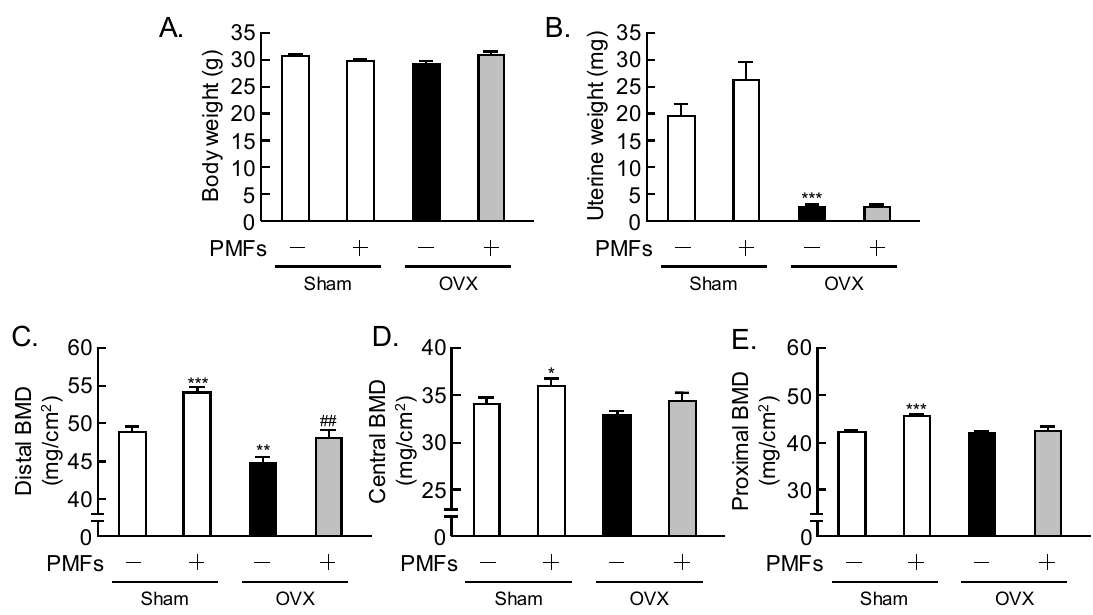
Figure 2. PMFs restored bone loss due to estrogen deficiency in mice. Female mice were ovariectomized (OVX) and sham-operated, and some mice were orally administered PMFs (5 mg/day/mouse) daily. At 4 weeks after the surgery, the body weight ( A ) and uterine weight ( B ) were measured. The distal BMD ( C ), central BMD ( D ), and proximal BMD ( E ) of the femurs were measured by dual X-ray absorptiometry. Data are expressed as the means ± SEM of 6–8 mice. Significant differences between the two groups are indicated; * p < 0.05, ** p < 0.01 and *** p < 0.001 vs. Sham without PMFs, ## p < 0.01 vs. OVX without PMFs.